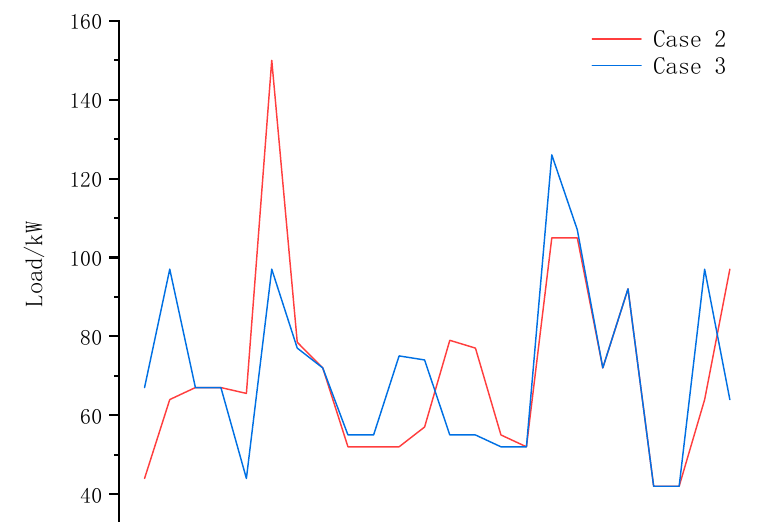
Figure 9. The load response of TOD tariff and real-time price.